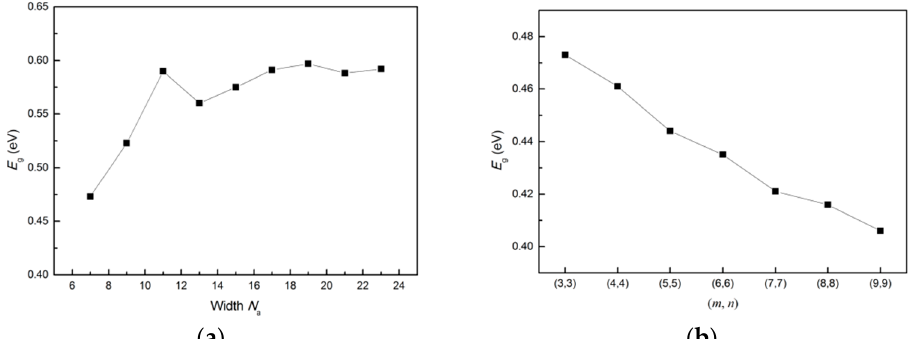
Figure 16. ( a ) Band gap variation in armchair nanoribbons N a -ac-(MoS 2 ) 3 /(WS 2 ) 3 -NR-sym (7 ≤ N a ≤ 23) as a function of nanoribbon width N a . ( b ) Band gap variation in armchair nanoribbons 7-ac-(MoS 2 ) m /(WS 2 ) n -NR-sym as a function of superlattice period ( m , n ) in the range (3, 3) ≤ ( m , n ) ≤ (9, 9).